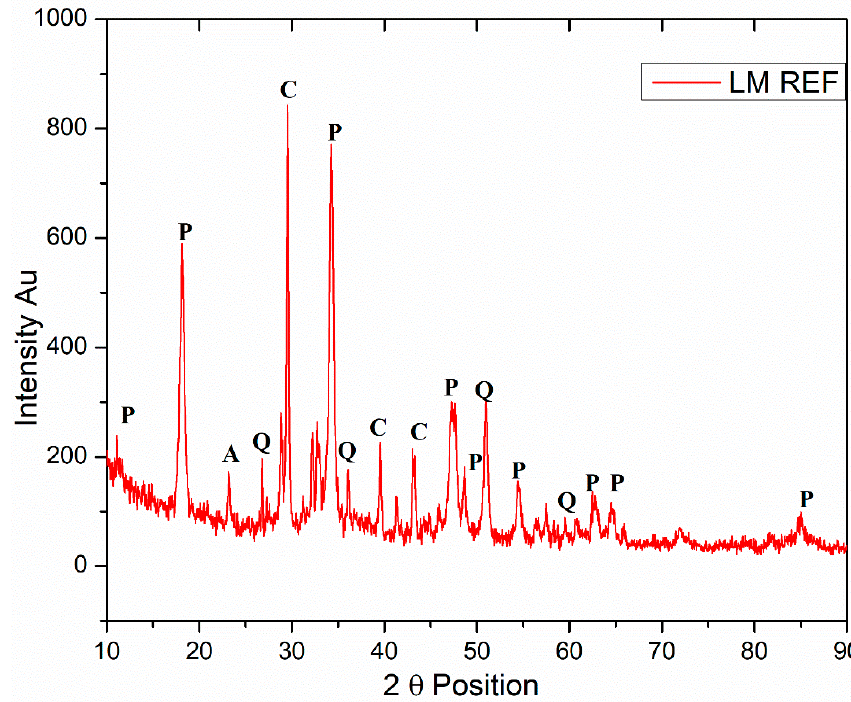
Figure 7. XRD patterns of the reference hydraulic lime mortar. P: portlandite, C: calcite, A: aragonite, T: tobermorite, Q: quartz, V: vaterite, W: Weddellite, G: gismondine-(CSH), AL: aluminium oxide.